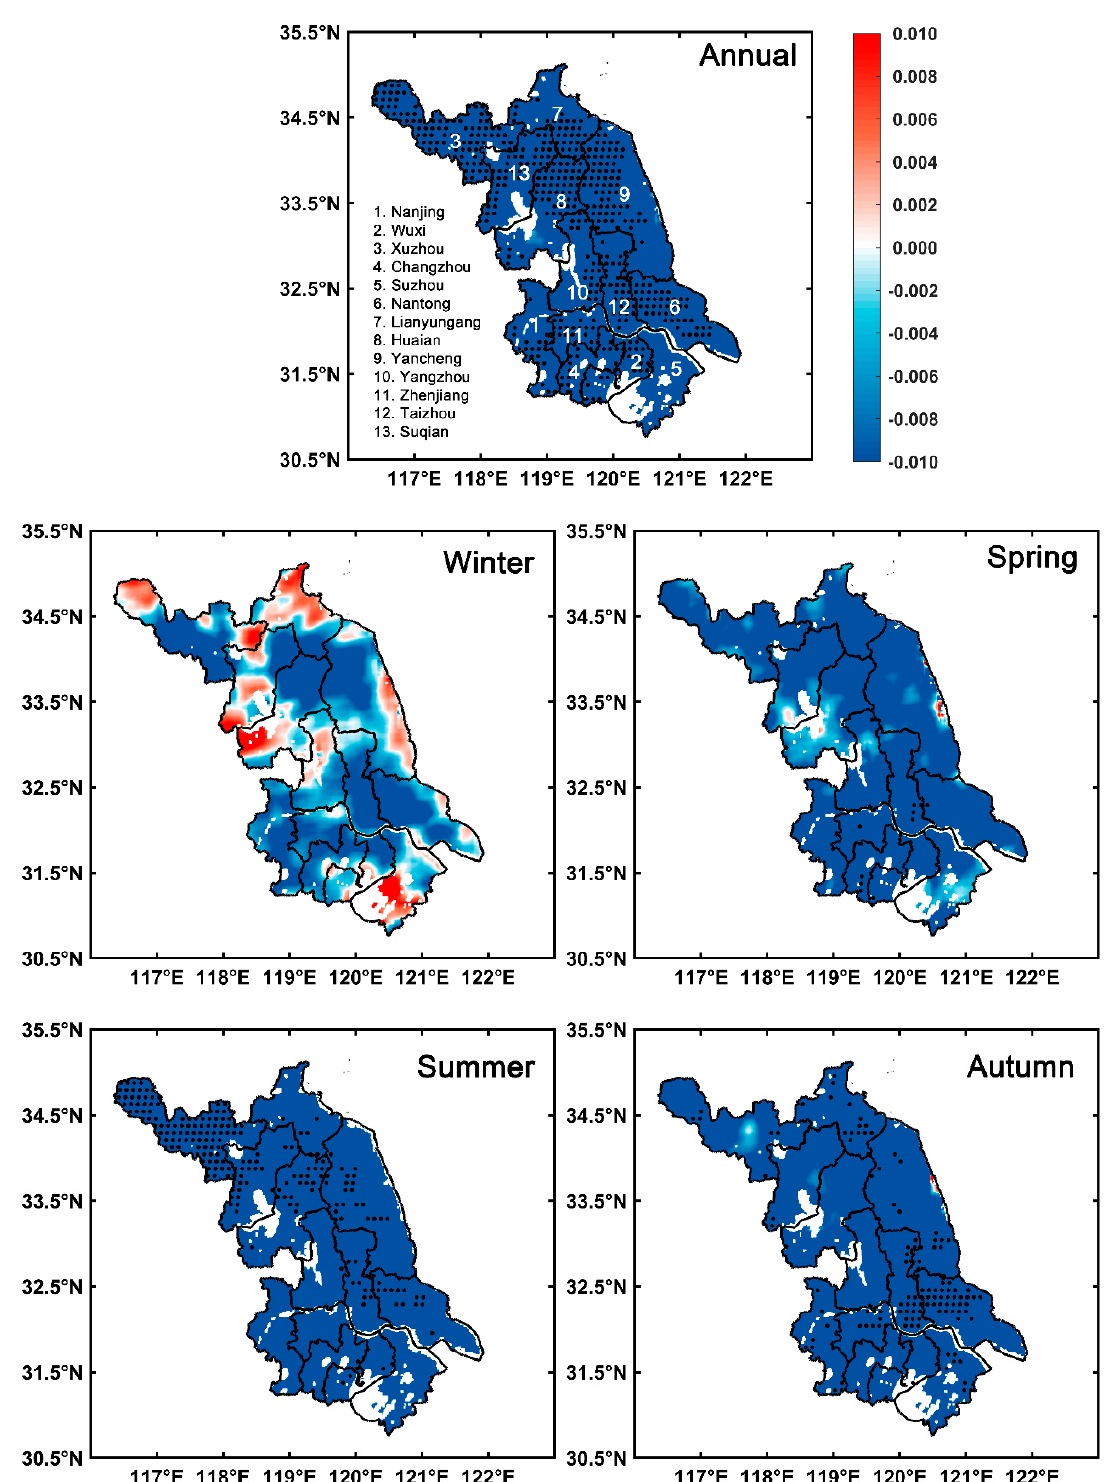
Figure 10. Annual and seasonal spatial trends of high-resolution MODIS MAIAC AOD from 2010 to 2019 in Jiangsu Province. The dot (.) symbol indicates significance at 95% confidence interval.